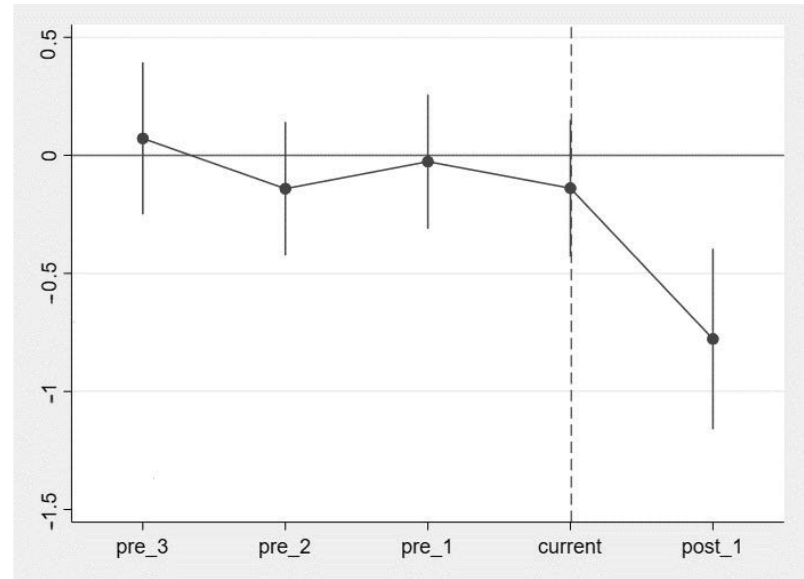
Figure 1. Parallel Trend Test.